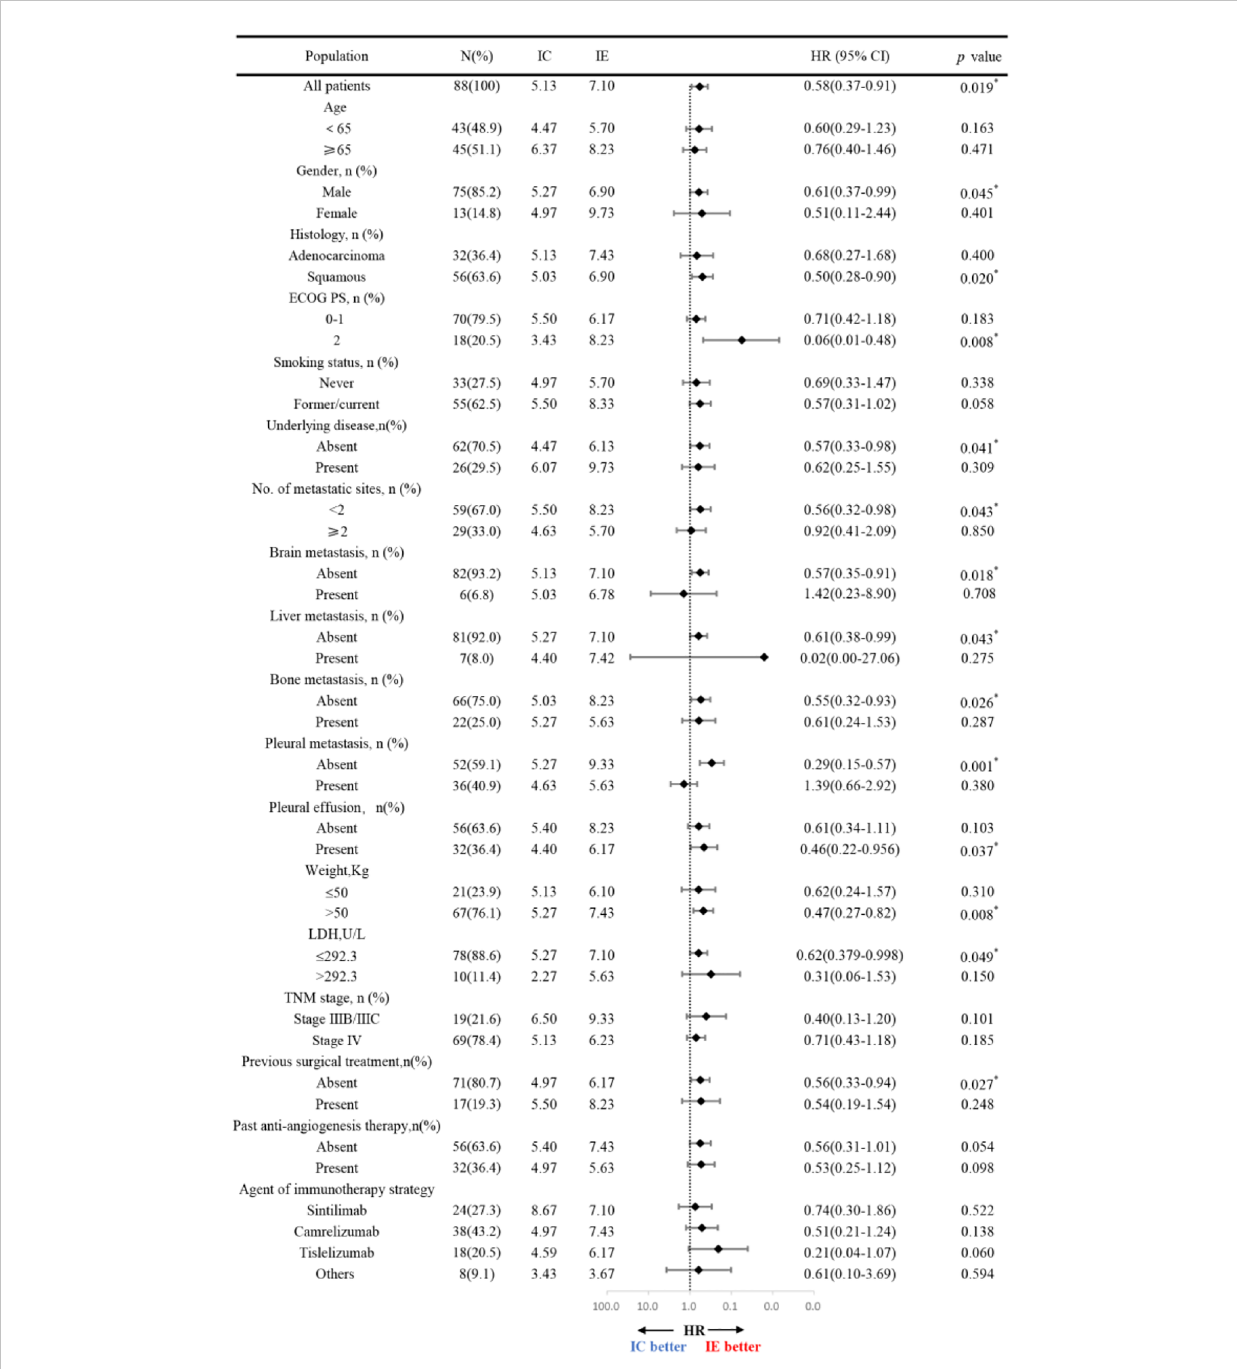
FIGURE 3 Hazard ratios for progession-free survival according to the baseline